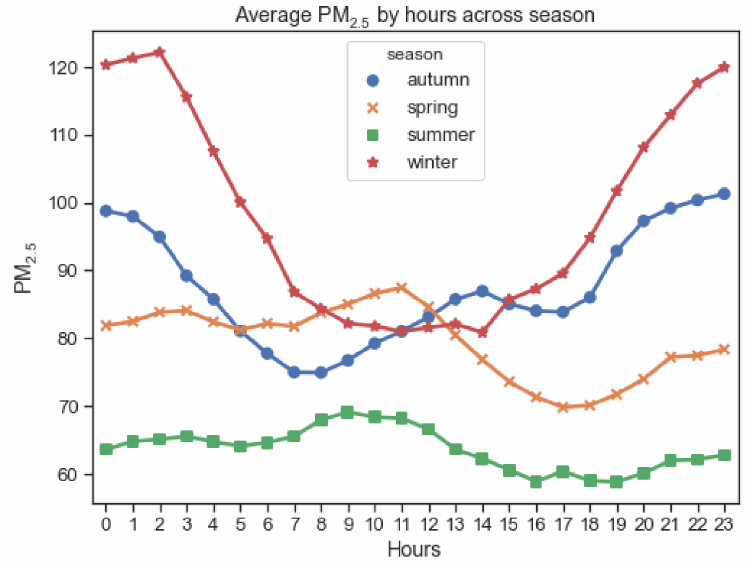
Figure 7. Average PM 2.5 concentration per hour in different